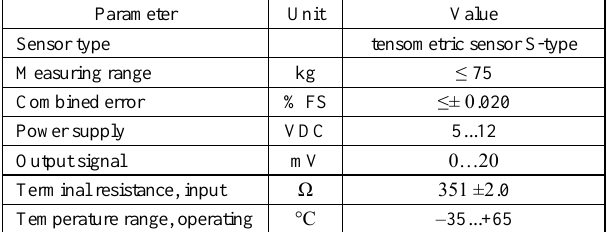
Fig. 4. Torque measuring system on the high-pressure pump shaft: 1 – high pressure pump, 2 – mounting plate, 3 – frame, 4 – frame pins, 5 – bearing housing, 6 – distance column, 7 – load cells sensor Table 2. Technical parameters of ZEMIC load cells sensor H3-C3-75 kg [27]